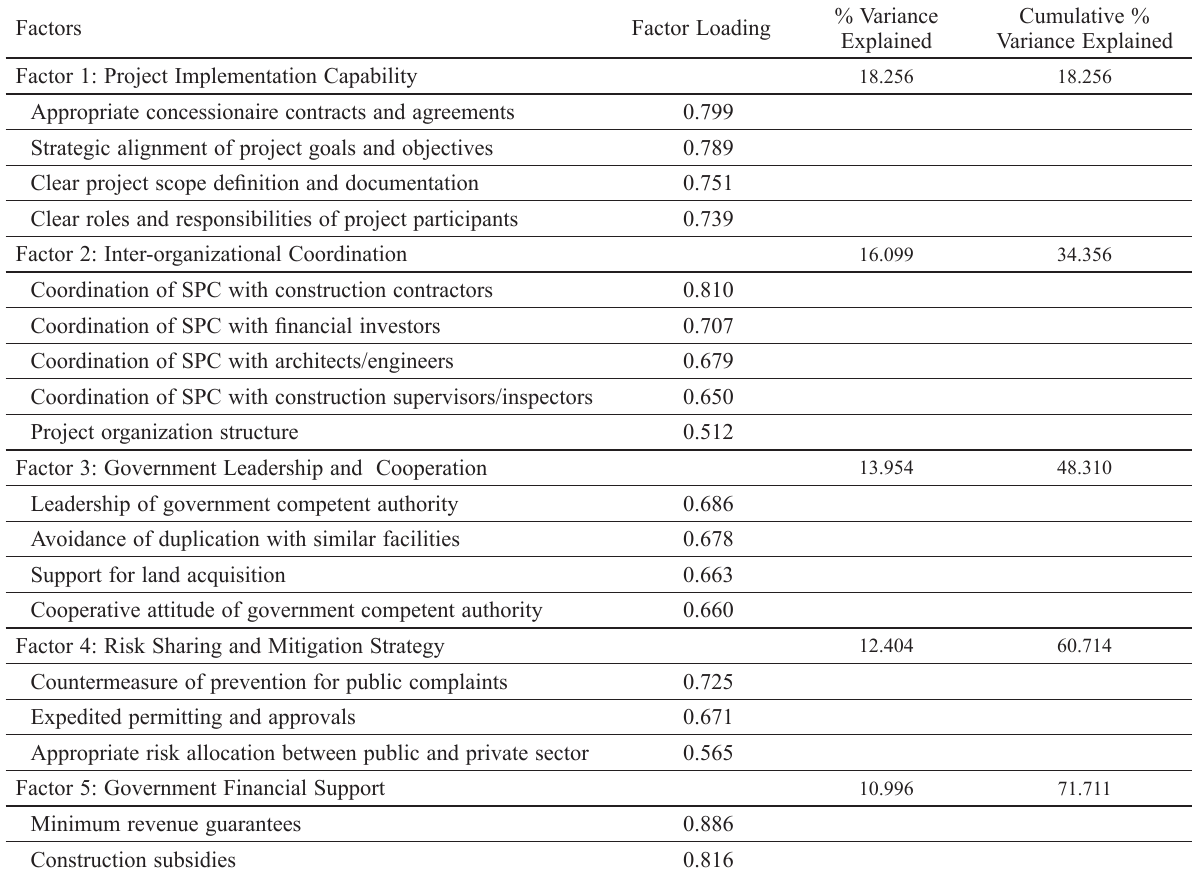
Table 3. Factor structure of organizational factors for the PPP projects